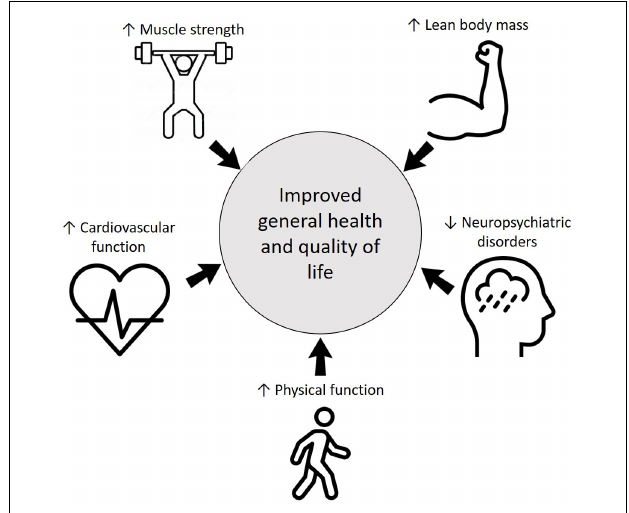
FIGURE 1 | Multi-system benefits of resistance